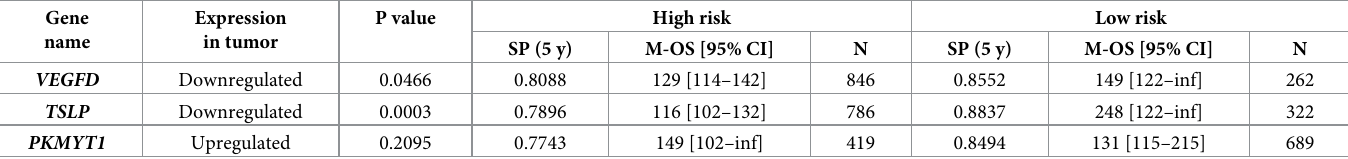
Table 4. Results of survival analysis for high-risk and low-risk groups according to three genes.